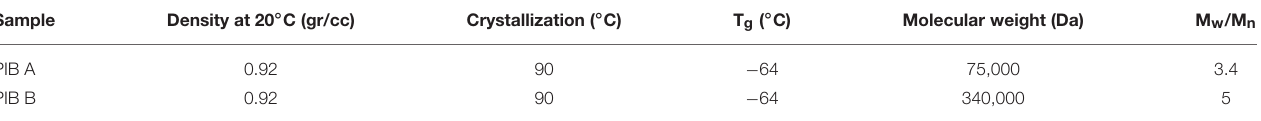
TABLE 2 | Properties of PIB samples used in this study.